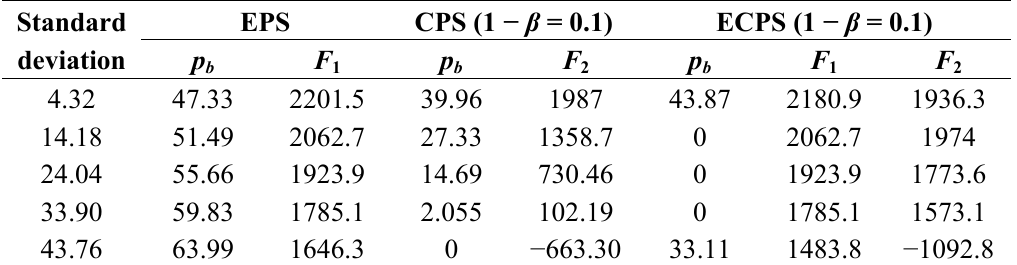
Table 5. Comparisons of the impact of the standard deviation on bidding